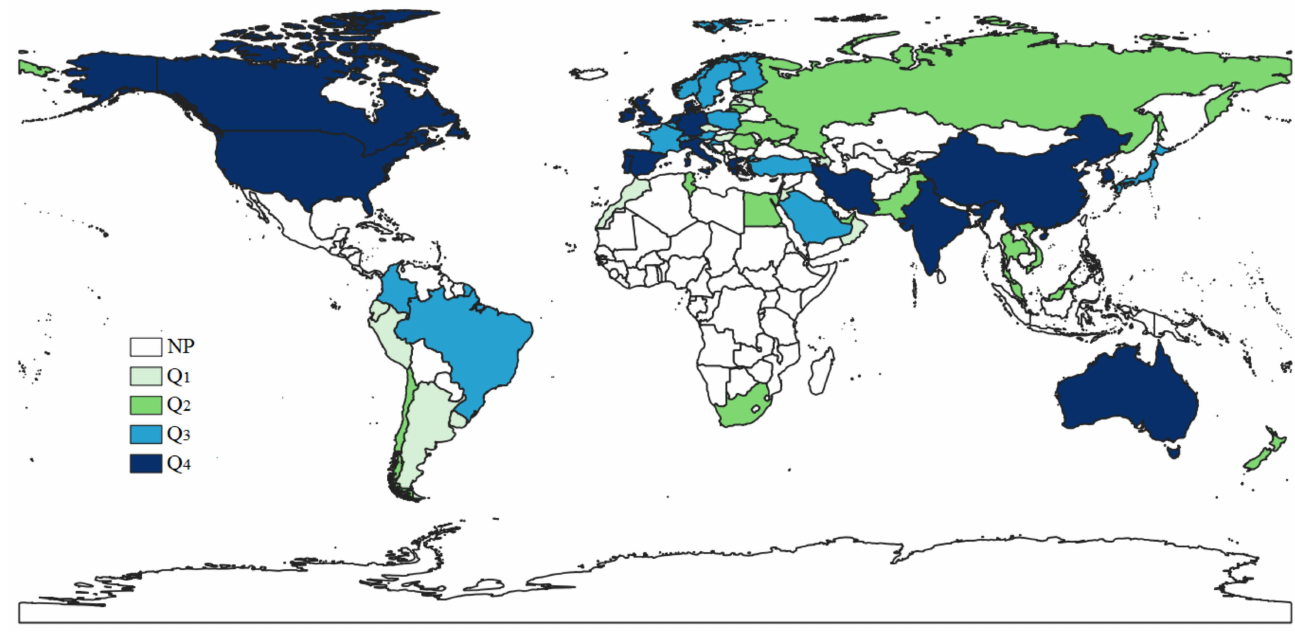
Figure 7. Worldwide overview on scientific production. Source: own study using data from